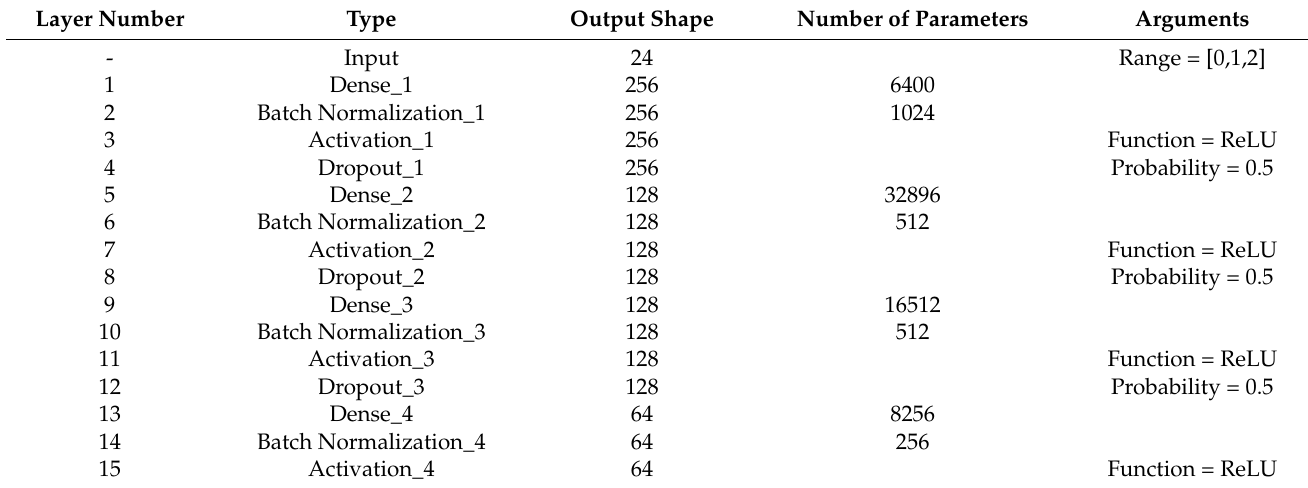
Figure 7. Structure of the deep neural network (DNN) for classification of the weld gap. Table 6. Training network structure of the DNN used in this study (structure 3).